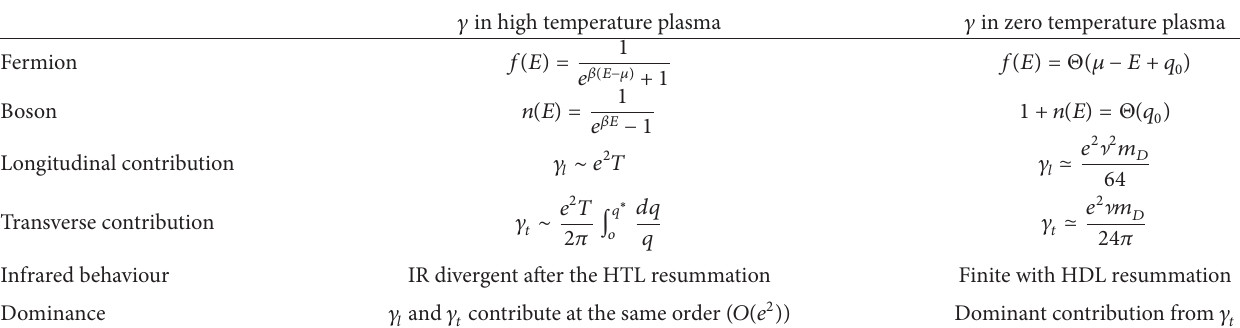
Table 1: Comparison of high and zero temperature damping